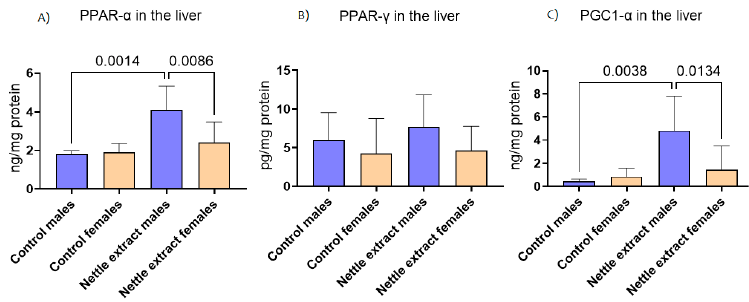
Figure 1. The changes in PPAR- α , PPAR- γ and PGC1- α in the liver of C57Bl6 mice treated with nettle extract. The numbers above bars are p values meaning statistically significant ( p ≤ 0.05) differ- ences between the treated groups by Kruskal–Wallis ANOVA.